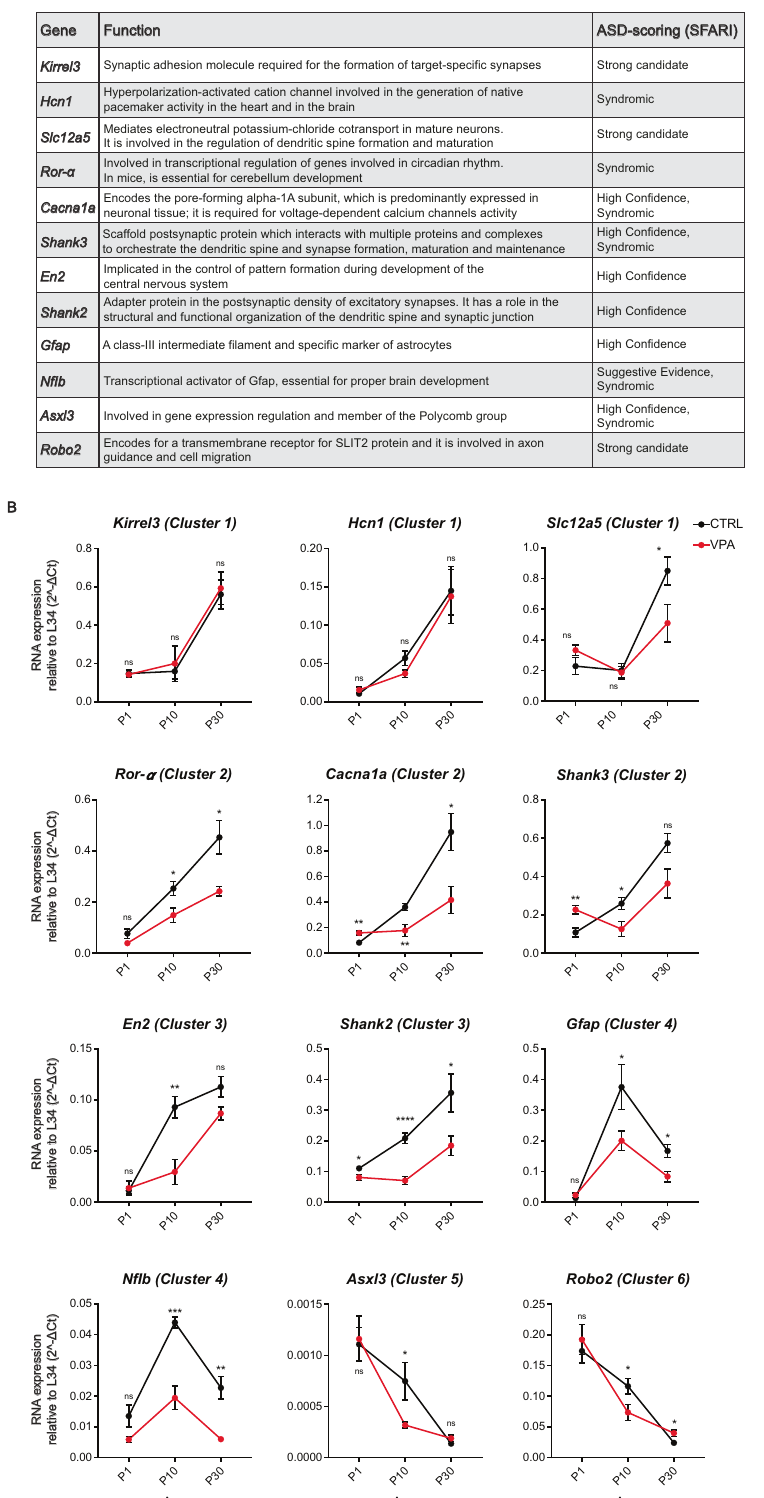
Fig. 4 Expression of ASD-associated genes is altered in VPA-treated mice. A List of the genes selected for their strong association with ASD. B Analysis by qPCR of the genes described in A in Ctrl and VPA mice at P1, P10, and P30. Data are expressed as: mean ± SEM, n = 6, * p value ≤ 0.05; ** p value ≤ 0.01; *** p value ≤ 0.001; **** p value ≤ 0.0001; number = not signi fi cant; statistical test = two-way ANOVA Tukey ’ s multiple